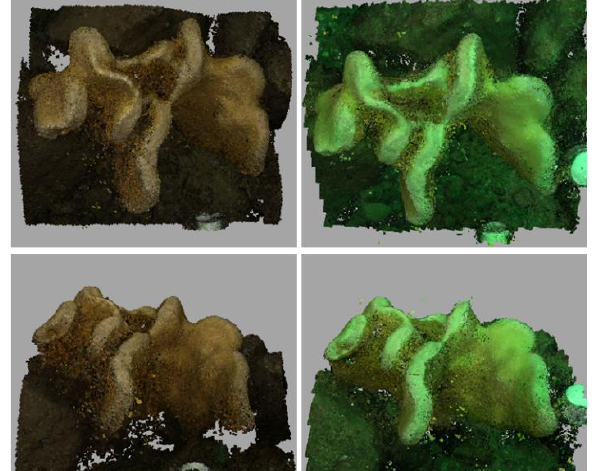
Figure 7. The dense point clouds from Survey 4 (left) and Survey 5 (right). Other than the obvious colour difference, photographs and extracted images seem to produce point clouds capable of documenting glass sponge morphology.